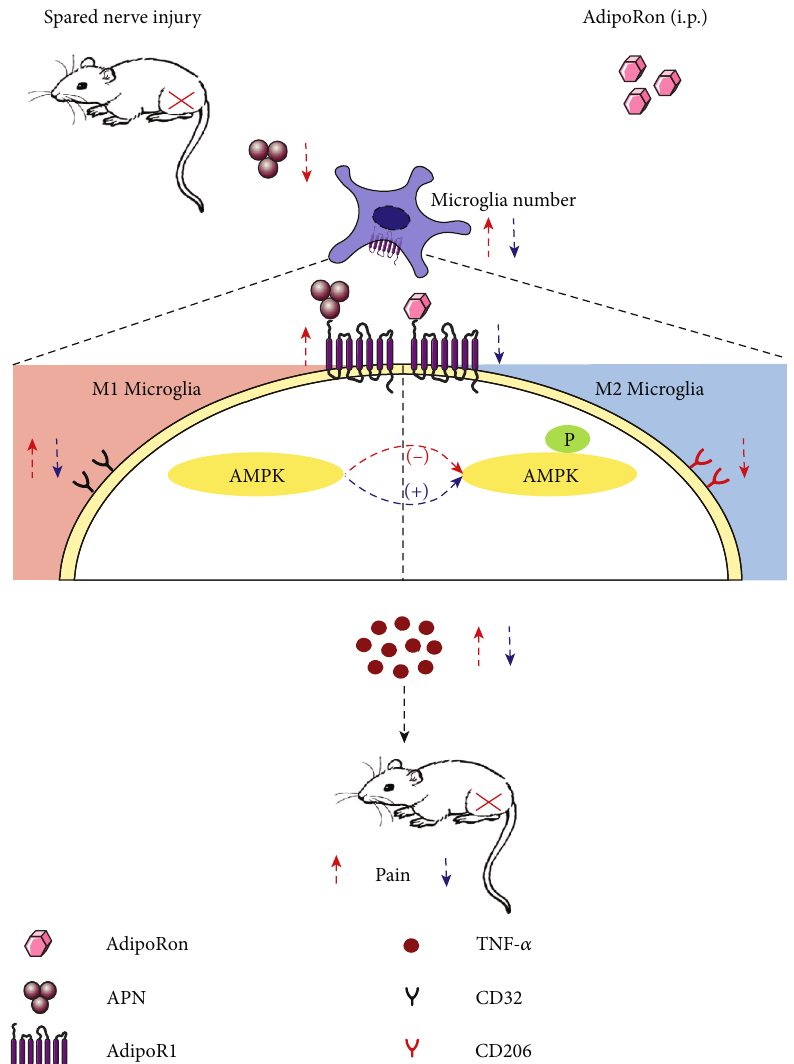
Figure 6: Schematic illustration of the analgesic e ff ect of AdipoRon. AdipoRon reduced M1-type microglia through the AdipoR1/AMPK pathway to inhibit TNF- α expression and improve mechanical nociception. The red arrows represent the pathological process, and the blue arrows represent the AdipoRon e ff